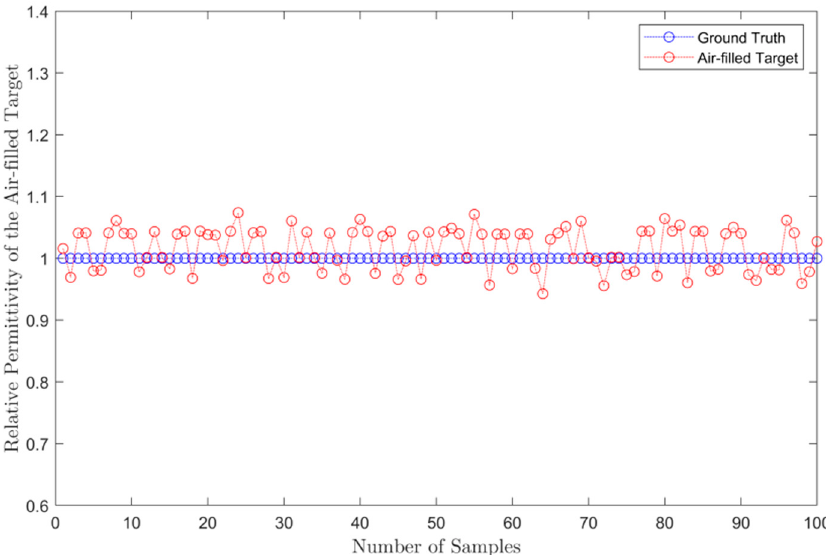
Figure 17. The predicted results on the field data set.